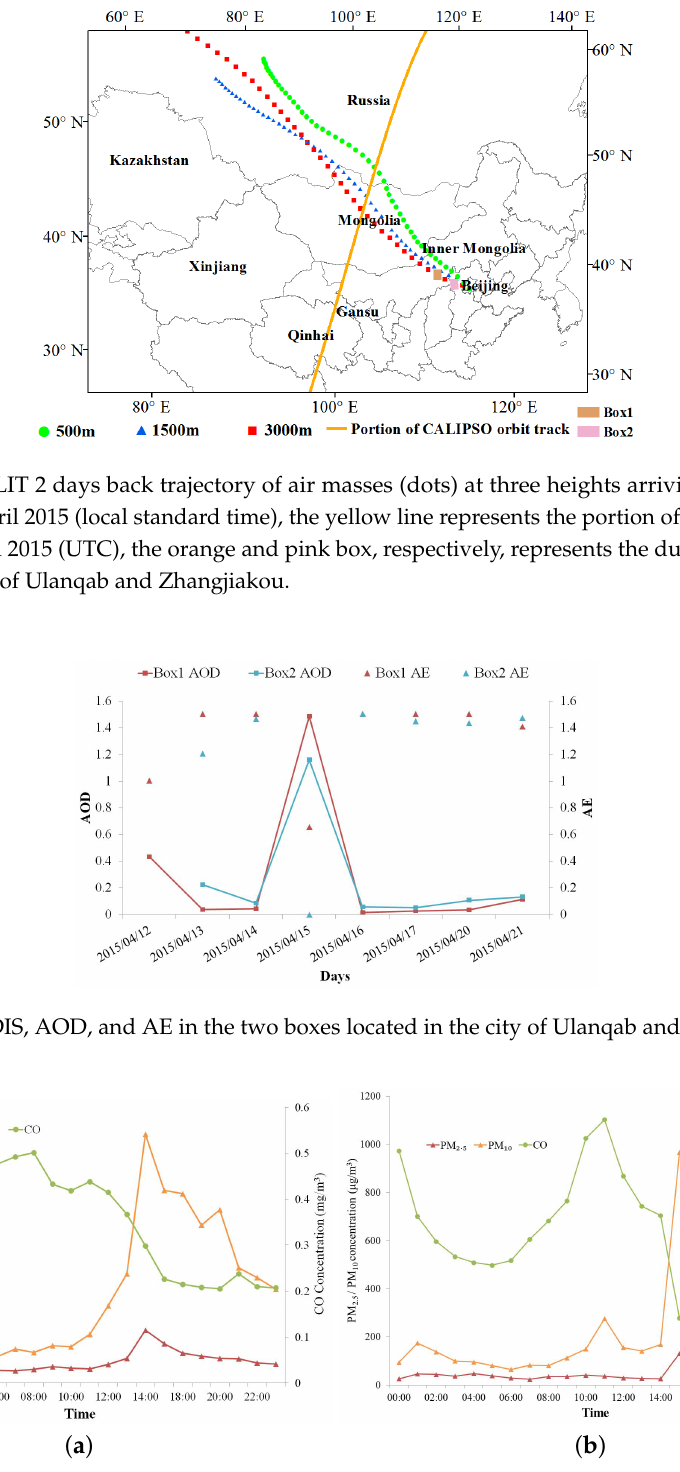
Figure 4. Hourly variations of PM 2.5 , PM 10 , and CO concentrations in the city of Ulanqab ( a ) and Zhangjiakou ( b ) on 15 April 2015 (local standard